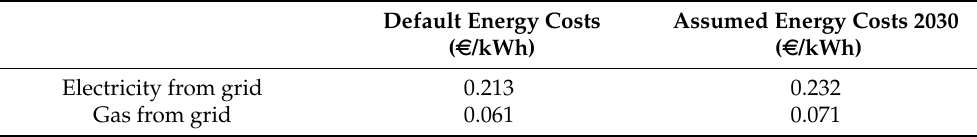
Table 10. Energy costs’ increase due to an increase of CO 2